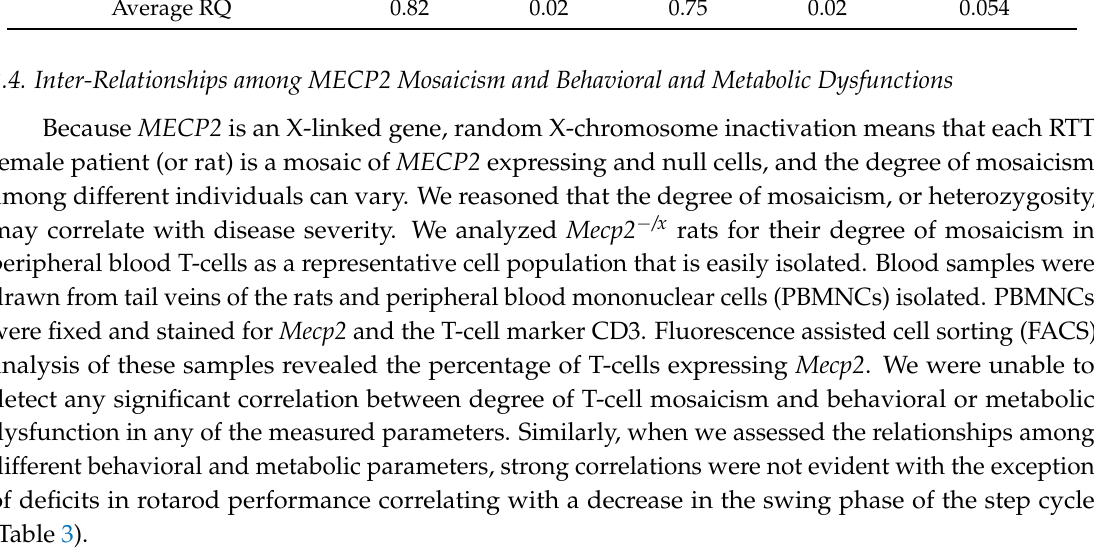
Table 3. Summary of regression analyses performed among behavioral measurements in Mecp2 − /x rats. Parameters Compared R 2 Adjusted R 2 Weight gain rate and day time food